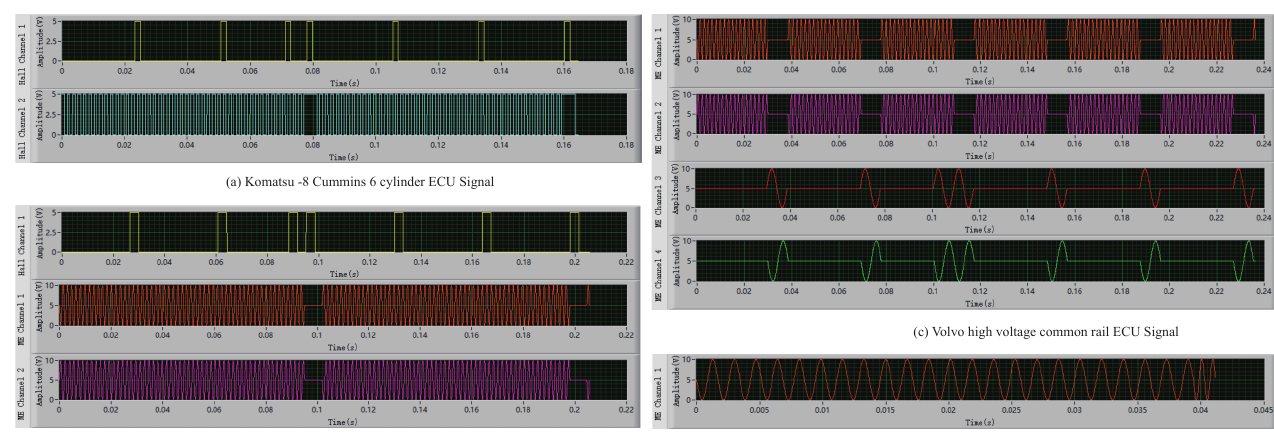
Figure 17. Excitation signals for four types of